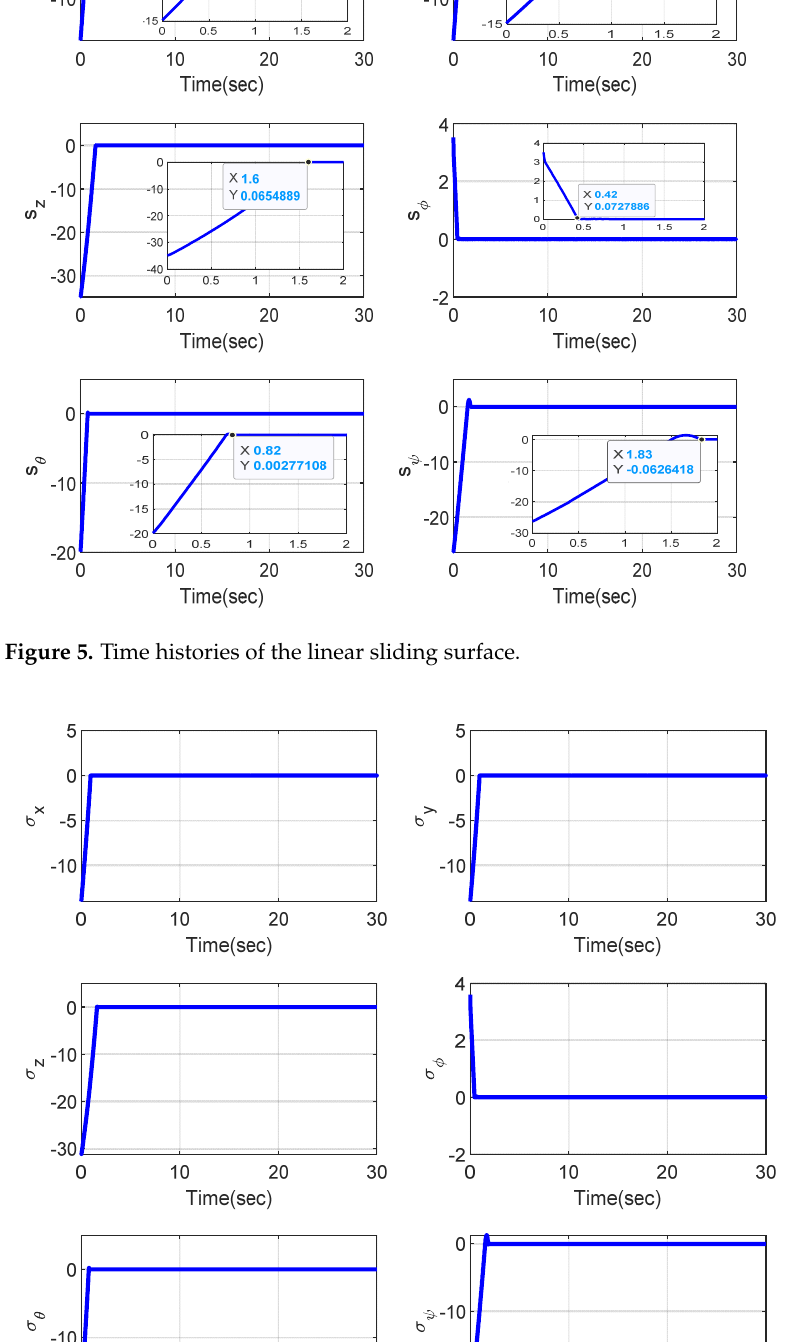
Figure 4. Trajectory of the tracking errors.